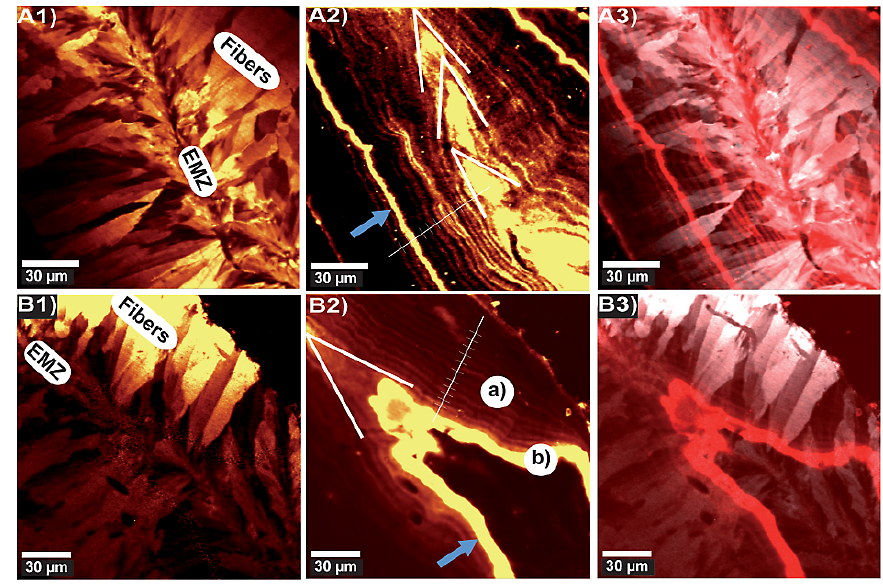
Fig. 4. Raman maps obtained on longitudinal thin sections ( A and B ) of the skeleton of P. lutea . Numbers indicate the spectral region used for the maps: (1) represents the intensity distribution of the symmetric stretch of aragonite (1085cm − 1 ) ; (2) the fluorescence intensity distribution; and (3) shows the superposition of map (1) and (2) . Blue arrows indicate organic-rich growth lines (ORGL 2) showing increased fluorescence within fluorescence maps. White arrowheads represent the oblique traces of the position of mineralizing epithelium forming layered growth increments with a high and a low fluorescence growth line comprising one growth cycle. The scale bar within fluorescence maps displays the skeletal extension for each growth cycle. The two types of growth lines within fluorescence maps are indicated in (B2) with (a) representing the incremental growth layers (organic-rich and organic-depleted growth lines) and (b) the high fluorescence growth lines (ORGL 2). (Superimposed images derived from WITec Project software.)